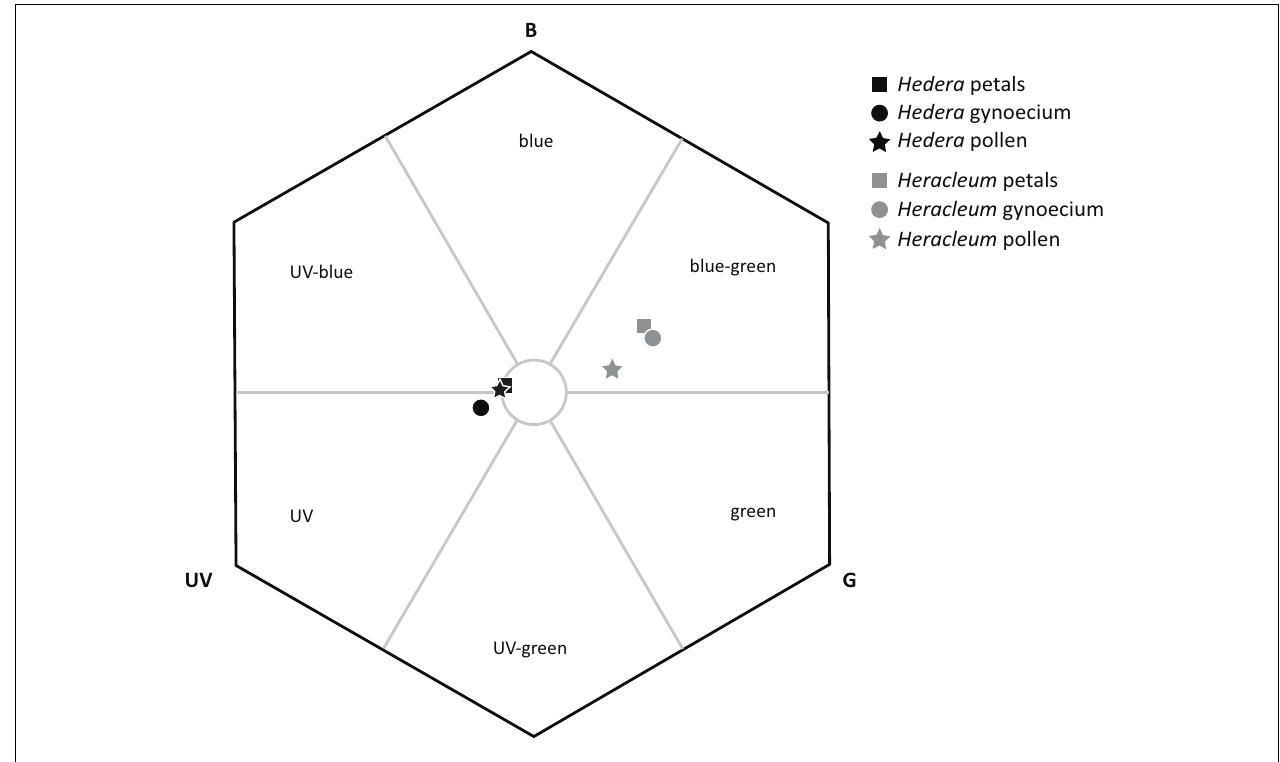
FIGURE 4 | Spectral color analysis of Hedera helix and Heracleum sphondylium floral organs, provided in a color hexagon based on the visual spectrum of Vespula germanica (B, blue; G, green; UV, UV receptor). A circle with 0.1 units in radius is given to demonstrate the region of background